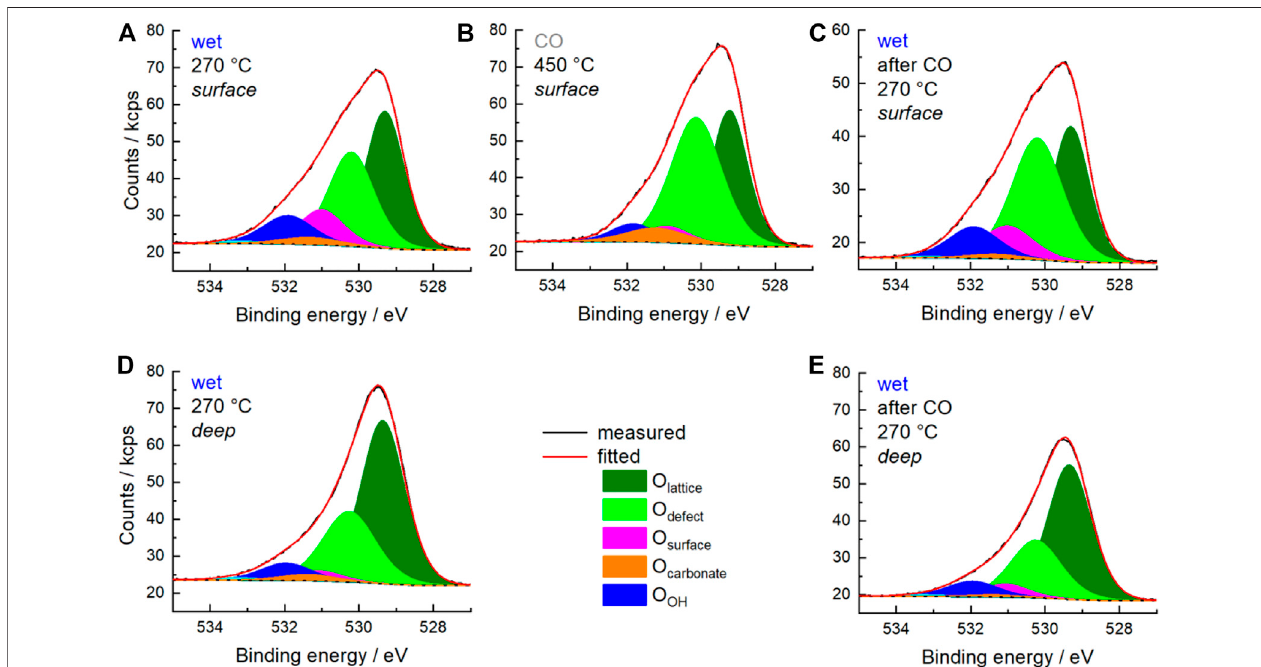
FIGURE 6 | Measured O 1s spectrum (black), fi tted spectrum (red) and background (black dots) measured in wet feed (C 3 H 8 /O 2 /He/H 2 O (cid:2) 5/10/45/40) at 270 ° C (A,C – E) and in 25% CO balanced by He at 450 ° C (B) . Fitted peaks of O species are depicted as follows: O lattice (olive) O defect (green), O surface (magenta), O carbonate (orange), and O OH (blue). (A – C) were measured with 700 eV excitation energy representing the surface region ( surface ). (D,E) were measured with 1,300 eV excitation energy representing information of deeper regions ( deep ).